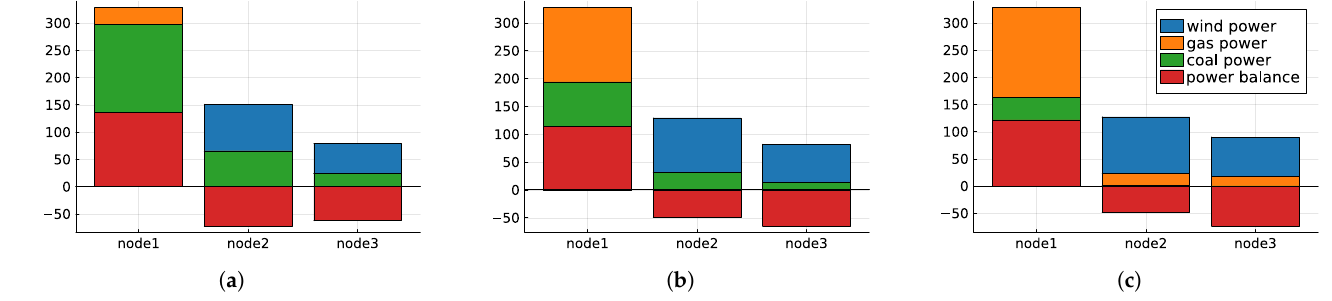
Figure 6. The disaggregation of nodal power balances are shown for three relevant scenarios. ( a ) SCC = 0; ( b ) SCC = 50; ( c ) SCC = 180.